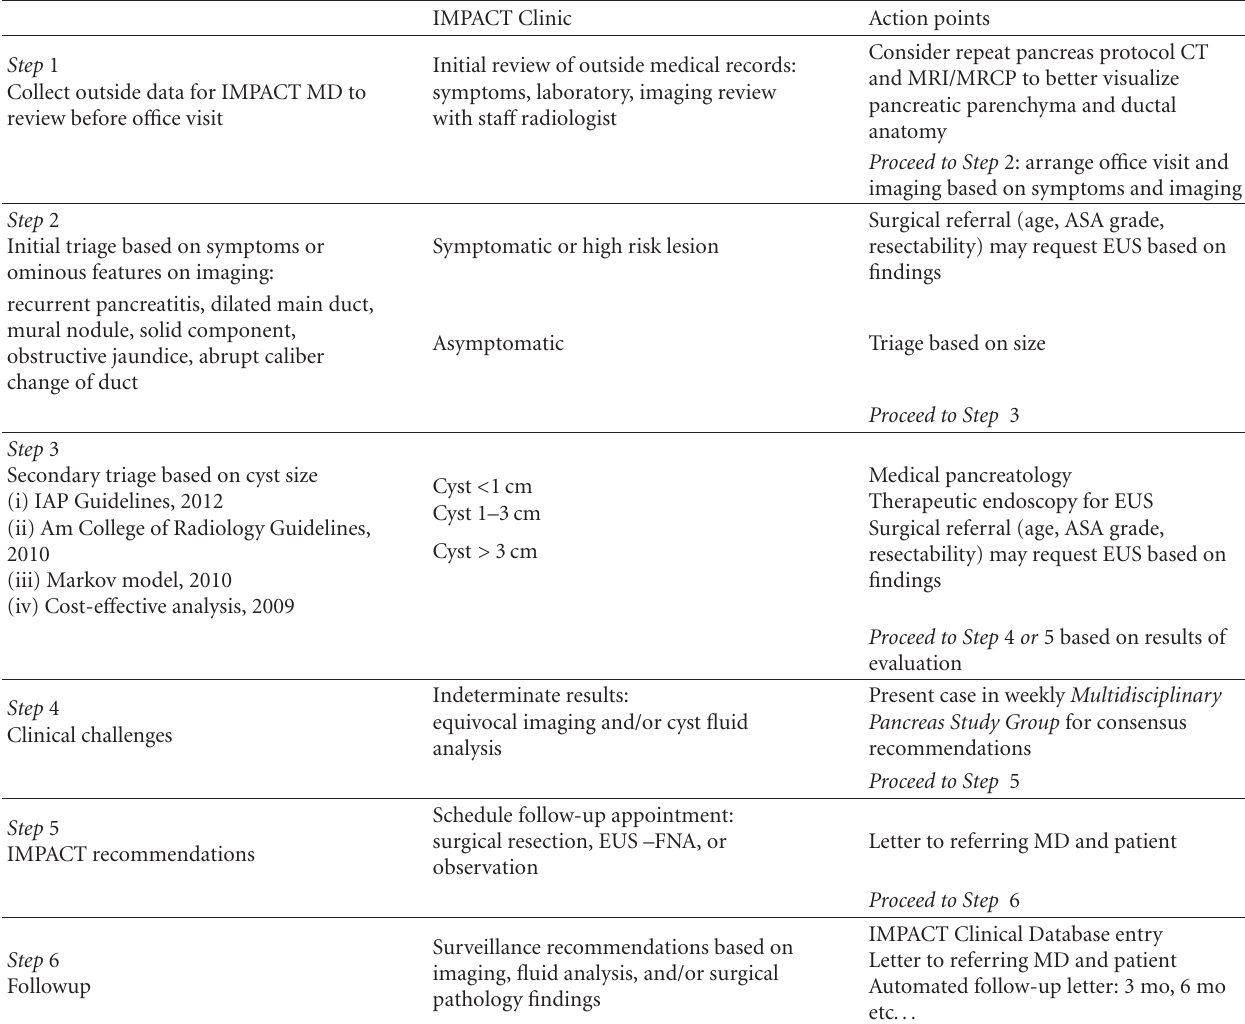
Table 2: Interdisciplinary management of pancreatic cystic